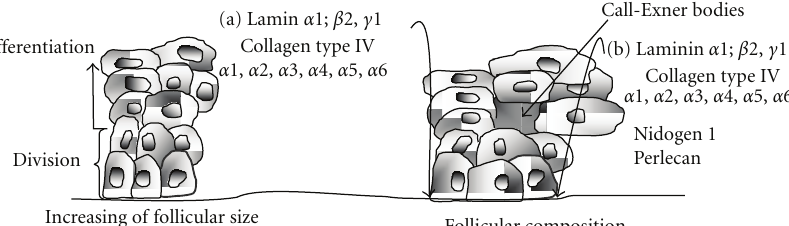
Figure 6: Morphology changes [6, 11, 12] Structure, function and change in the morphology of the granulosa cells [11], components of the basal lamina and the Call-Exner bodies of. (a) Primordial follicles and (b) preantral follicles [12]. With permission from Rodgers [11]. Table 4: Localization of EGF, TGF- α , EGF-R proteins and mRNA in the bovine ovary [28]. Cell type